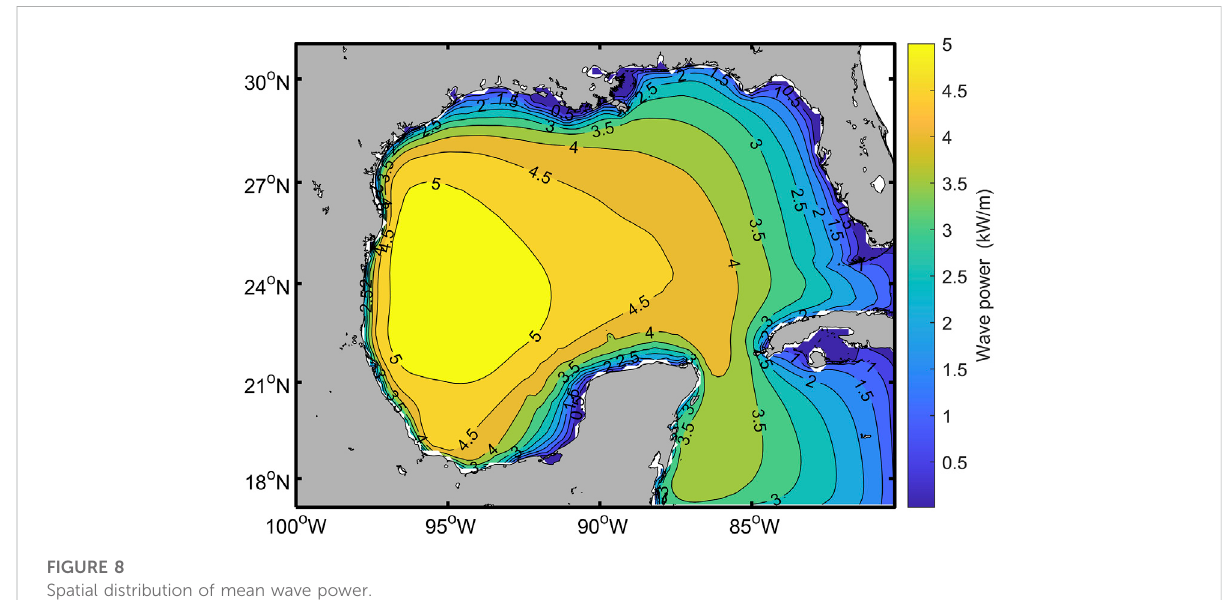
FIGURE 8 Spatial distribution of mean wave